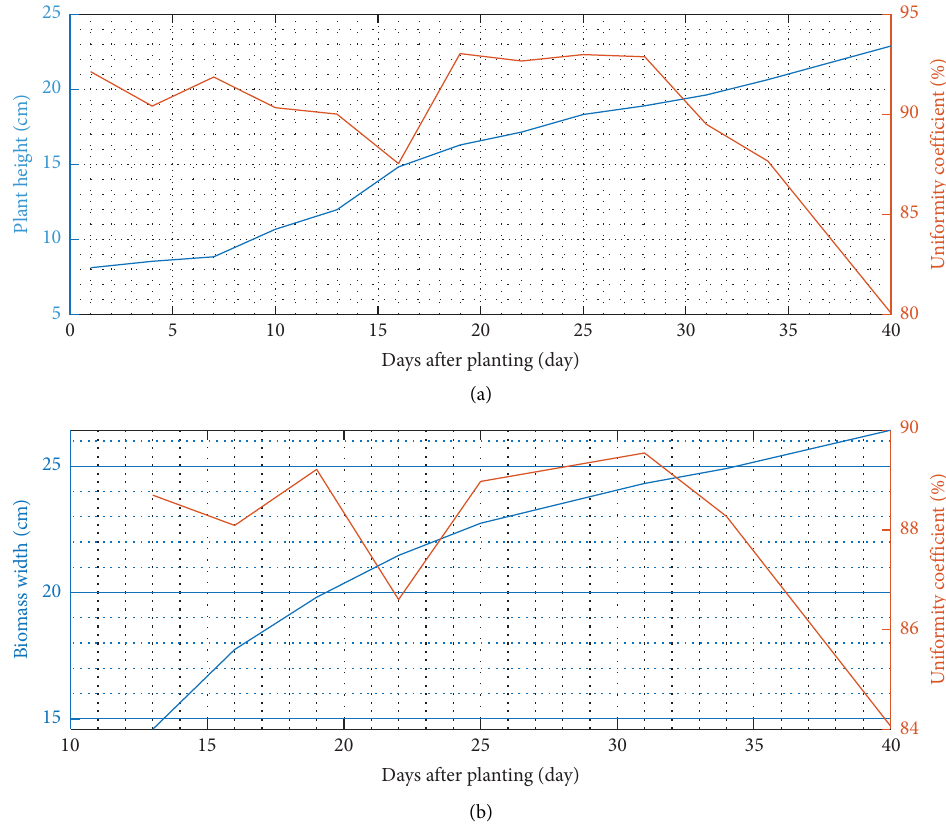
Figure 12: Pagoda mustard growth in the self-fertigation system: (a) plant height and (b) biomass width.